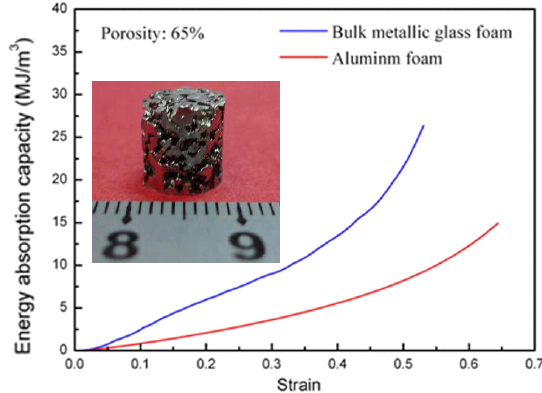
Figure 2. The comparison of the evolution the plastic energy absorption capacity between a Vit1 MG foam and a conventional Al foam, where the inset shows the morphology of the MG foam. Adapted from [8] with copyright permission from Elsevier, 2012.